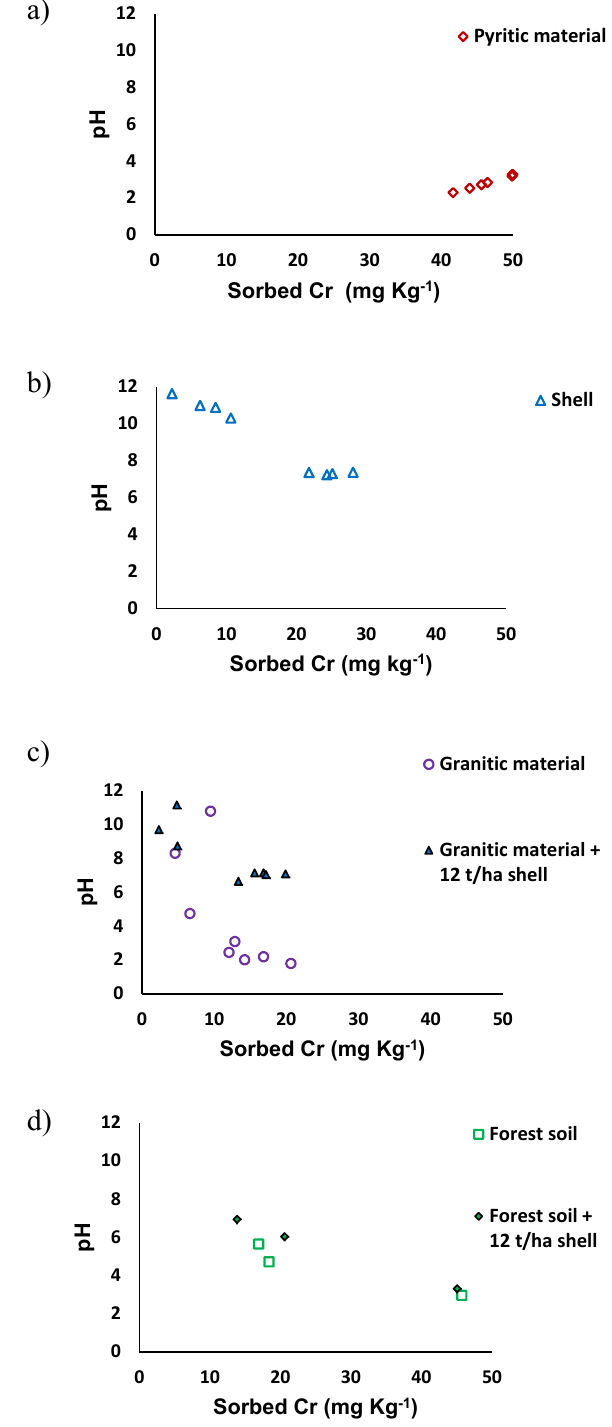
Figure 2. Relation between pH and sorbed Cr (mgkg − 1 ) for pyritic material (a) , mussel shell (b) , amended and unamended granitic ma- terial (c) , and amended and unamended forest soil (d) , after being added with 100mgL − 1 Cr. Mean values; triplicate samples with coefficient of variation